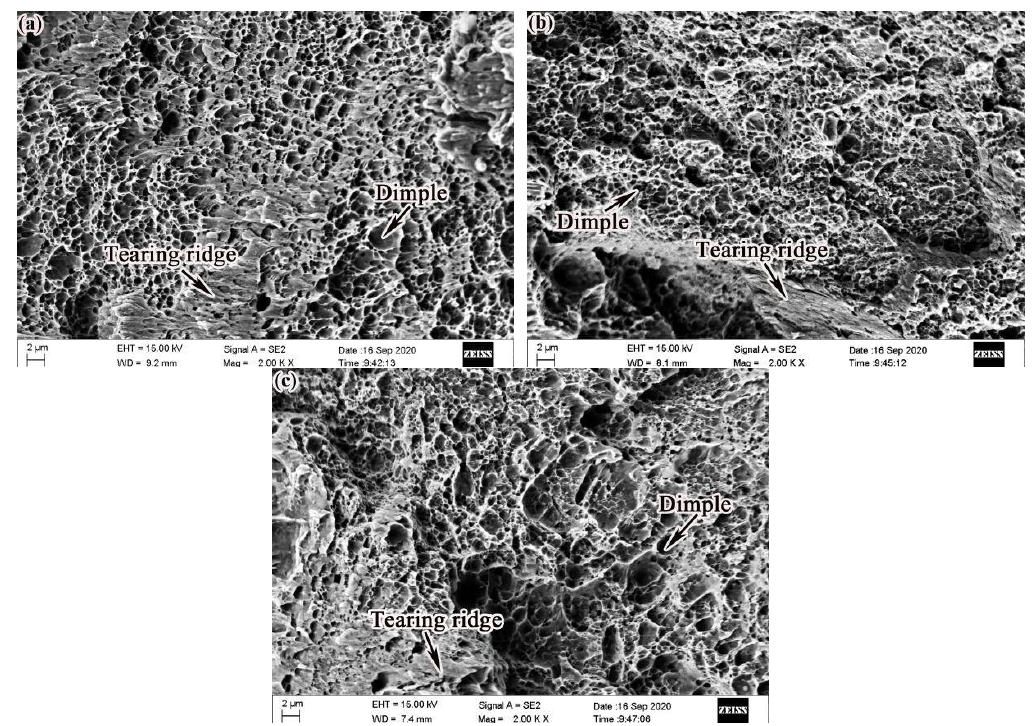
Figure 9. Tensile fracture morphology: ( a ) as-deposited; ( b ) QT; ( c ) SR.